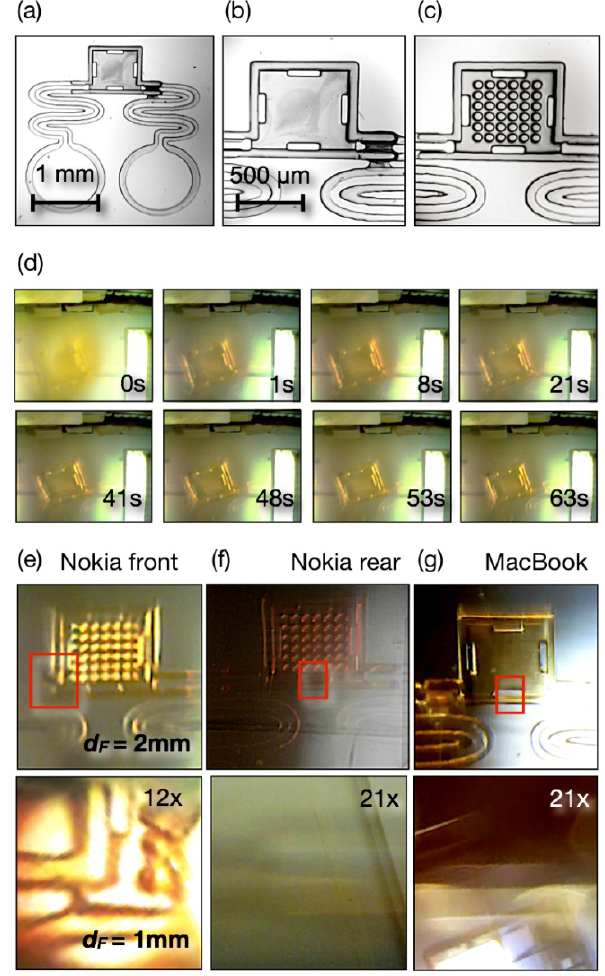
Figure 3. ( a ) Microscopy image of a 3D test microstructure at 25× magnification; ( b ) Detail at 100× magnification of one type of micro chamber used in this work; ( c ) Detail at 100× magnification of the second type of micro chamber used in this work; ( d ) Selected full frames (176 × 144 pixels, 8 bits per colour channel) from a 1 min video stream recorded with a Nokia 6720 cell phone front camera. The focus changes while the liquid lens evaporates and between 41 s and 53 s the best focus and depth of field is achieved; ( e ) Selected area of a microstructure imaged with a Nokia 6720 cell phone front camera operating in video mode for d = 2 mm and d = 1 mm in the lower panel, where an F F estimated 12× zoom factor is indicated; ( f ) Selected area of a microstructure imaged with a Nokia 6720 cell phone rear camera operating in 5 MP time-elapsed still image acquisition at 6 fpm for d = 2 mm and d = 1 mm in the lower panel, where an estimated 21× zoom F F factor is indicated; ( g ) Selected area of a microstructure imaged with a MacBook Pro camera operating in VGA (640 × 480 pixels) video mode for d = 2 mm and d = 1 mm in F F the lower panel, where an estimated 21× zoom factor is